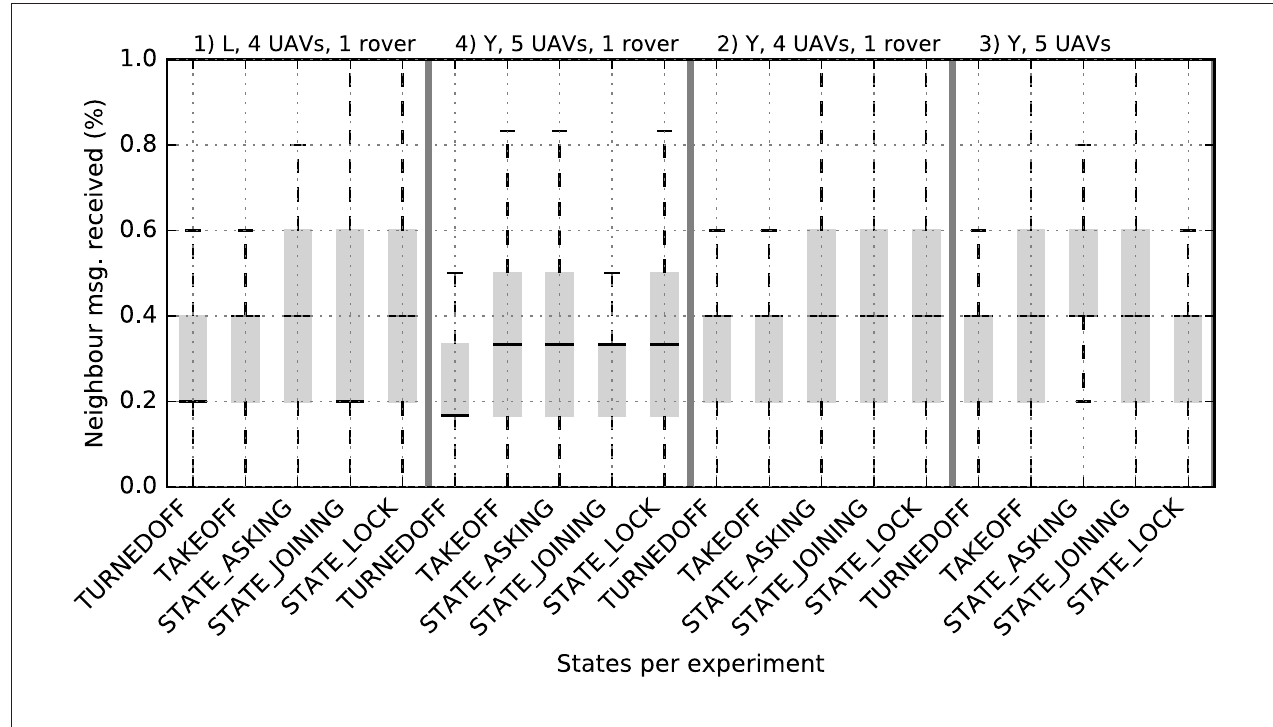
FIGURE 9 | Average ratio of neighbors messages received over the total swarm member for different